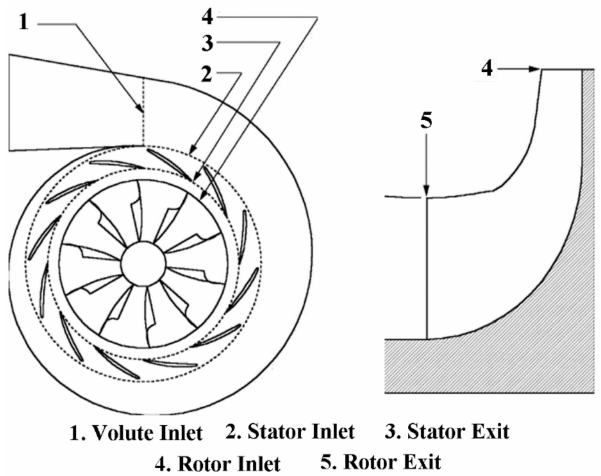
Figure 2. Design station for calculating geometric and aerodynamic parameters.